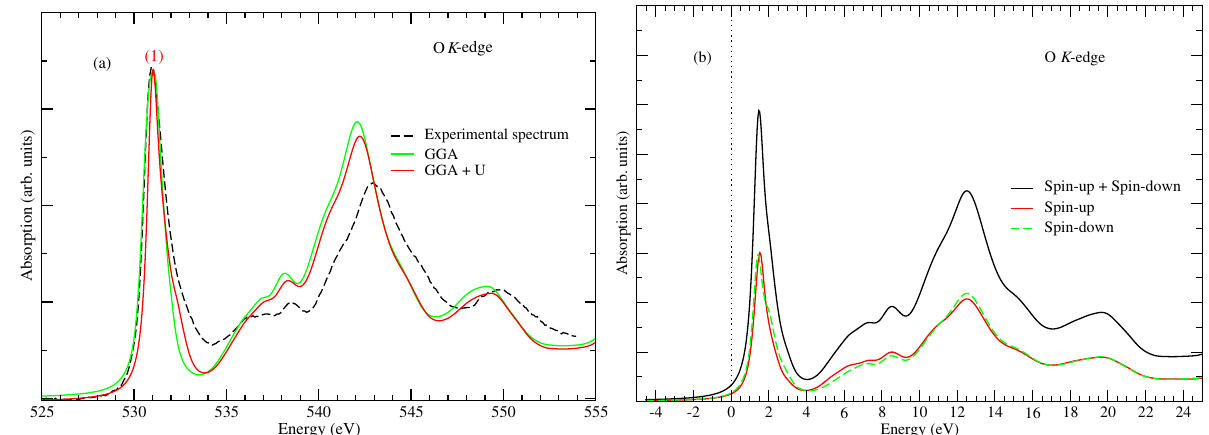
Figure 3. ( a ) O K -edge XANES spectrum calculated with the standard GGA functional (green line) and GG + U (red line) and the room temperature XAS spectrum recorded in TEY mode (black dashed line) for the Co 3 O 4 . ( b ) Spin-polarization dependence of the O K -edge XANES spectrum calculated with GGA + U , where the photon-absorbing oxygen atom is bounded to the cobalt atoms Co1, Co2, Co3 and Co4 as shown in the Co 3 O 4 crystal in Figure